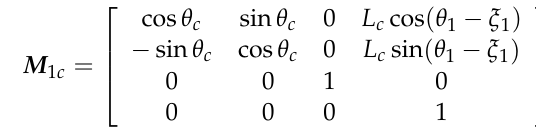
where θ c is the rotation angle of the generating gear around its own